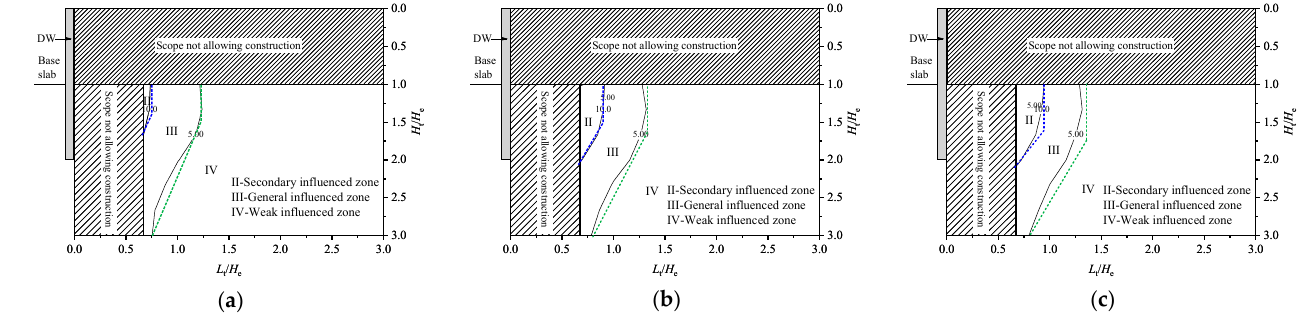
Figure 8. In fl uenced zone of deep excavation on adjacent tunnel displacement ( H e = 9 m): ( a ) δ hm = ( a ) δ hm = 0.18% H e ; ( b ) δ hm = 0.3% H e ; ( c ) δ hm = 0.7% H e . 0.18% H e ; ( b ) δ hm = 0.3% H e ; ( c ) δ hm = 0.7% H e .